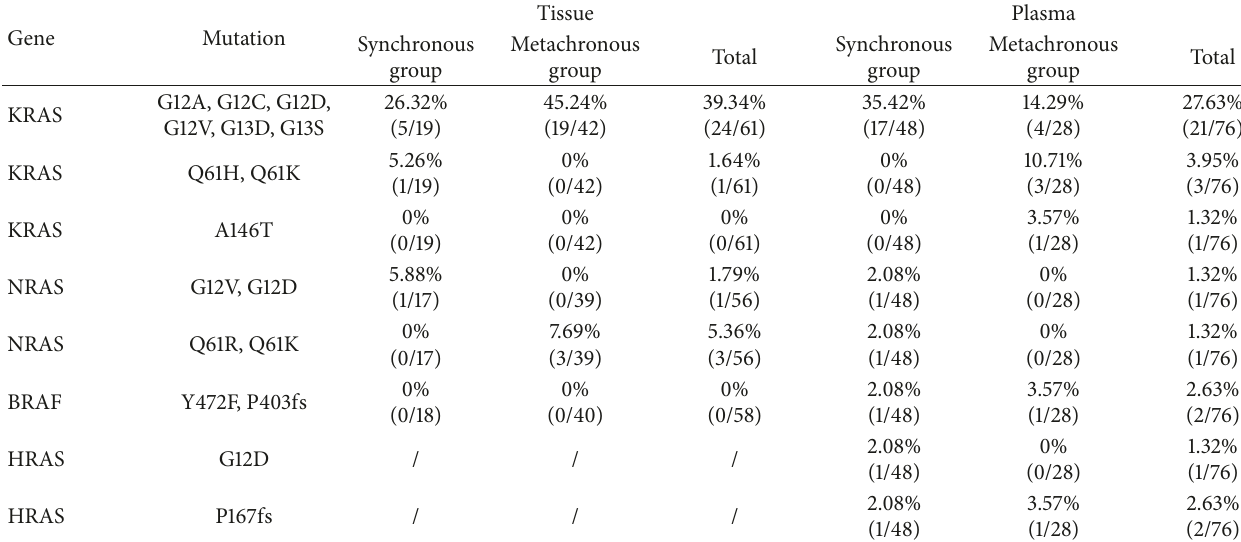
Table 2: Mutation types of RAS/BRAF detected in 76 patients.